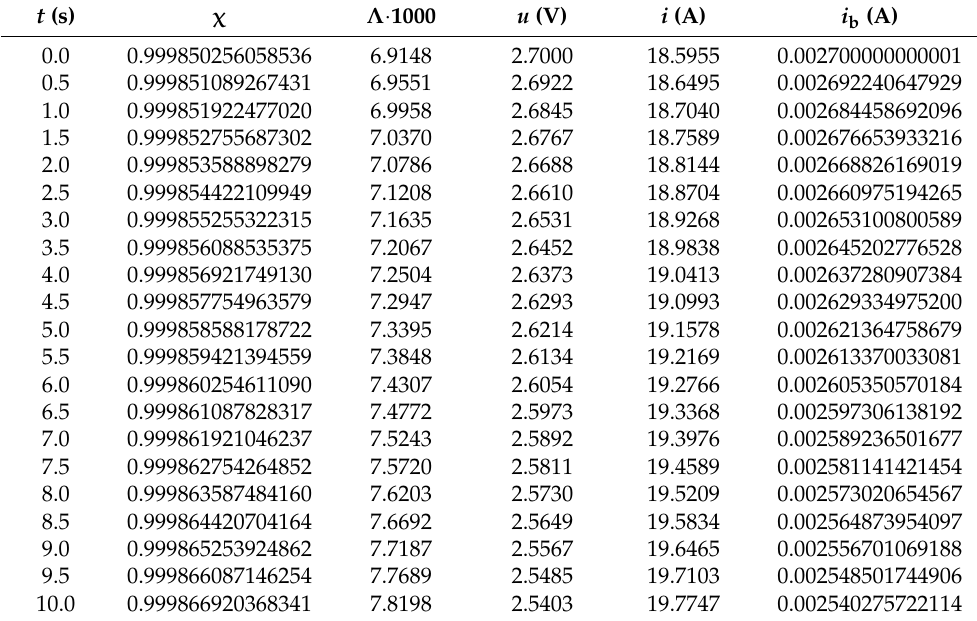
Table 3. Numerical results calculated in SC discharging, R b = 1000 Ω .